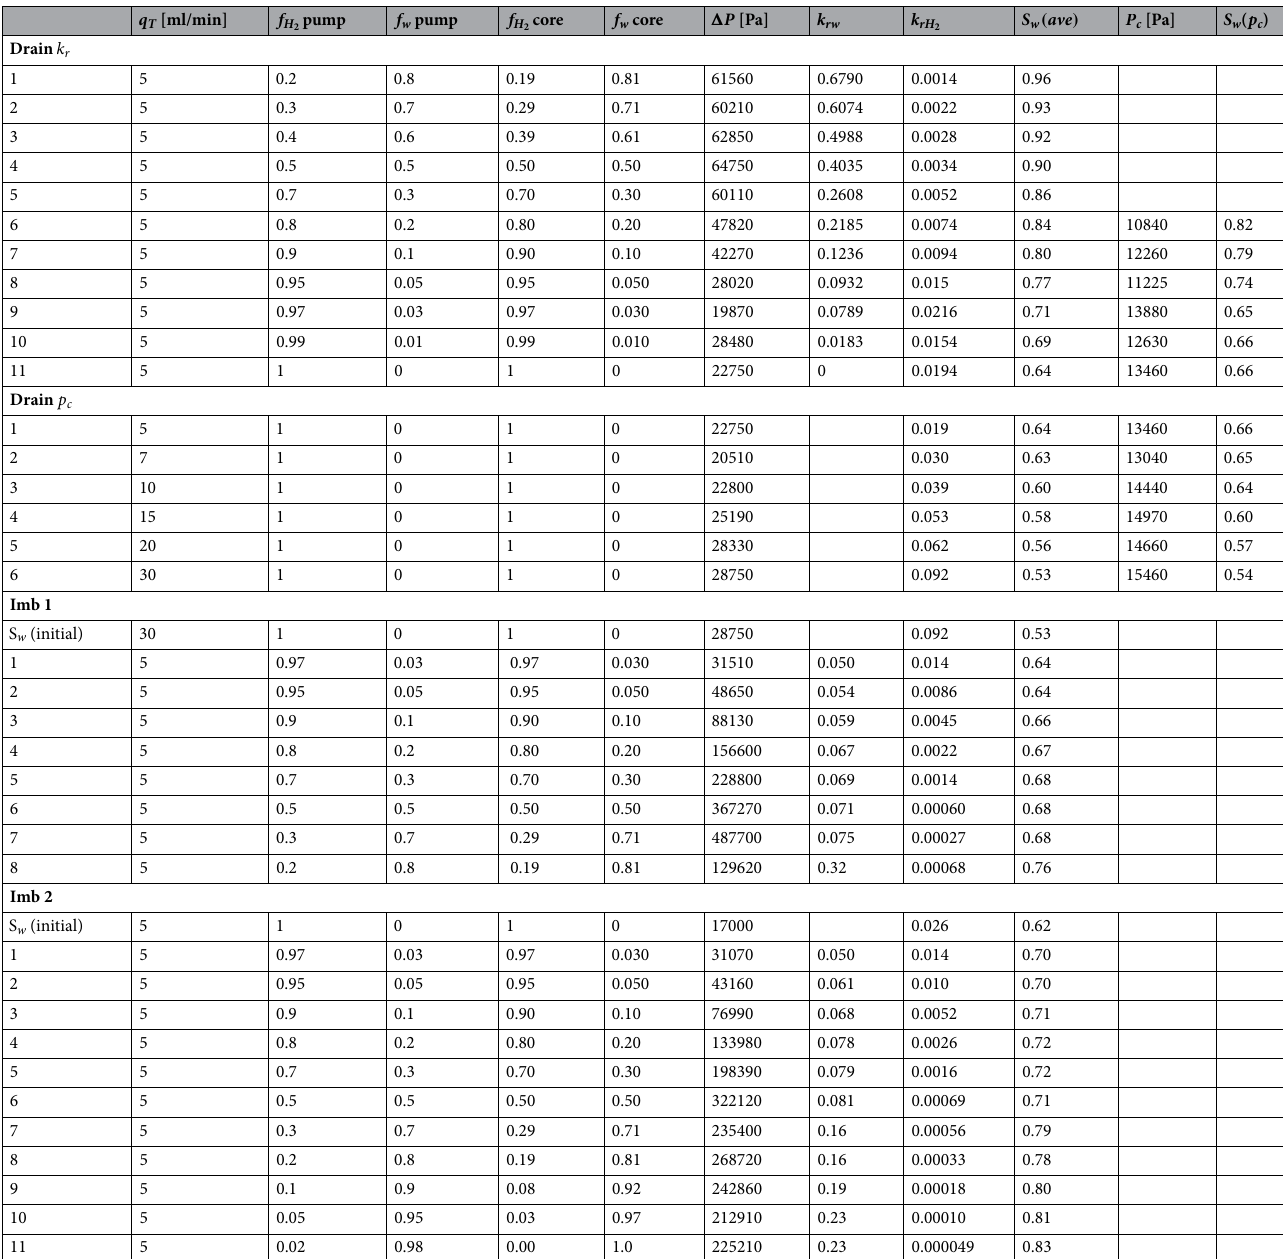
Table 1. Experimental conditions during each stage of the experiment. where, q T is the total injection rate (ml/min), f H and f w are the fractional flow of hydrogen and water, respectively. The fractional flow injected 2 from the pump is listed as well as the fractional flow that is obtained in the core once the water has equilibrated with hydrogen. The amount of dissolved H 2 for the conditions of the experiment is calculated using Henry’s law with K Pc H = 1300 L atm mol 44 . (cid:31) P is measured between the pressure tap at 2.25 cm from inlet and the pressure tap at 17 cm from the inlet (outlet). Please note that drainage p c (1) is the same measurement as drain k r